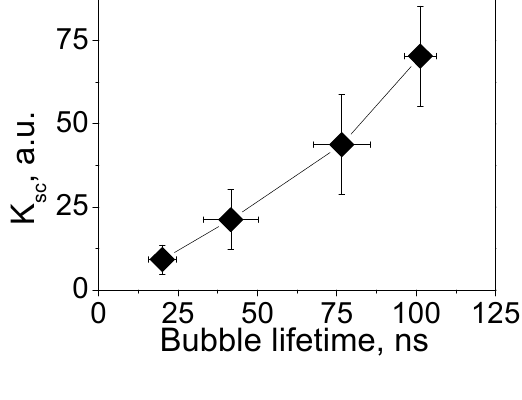
Figure 9. Influence of the fluence of a single pump laser pulse (532 nm, 0.5 ns) on the amplification of optical scattering signal by a PNB (relative to gold NPs) in NP-treated cells as a function of PNB lifetime ( i.e. , maximal size of the PNB)